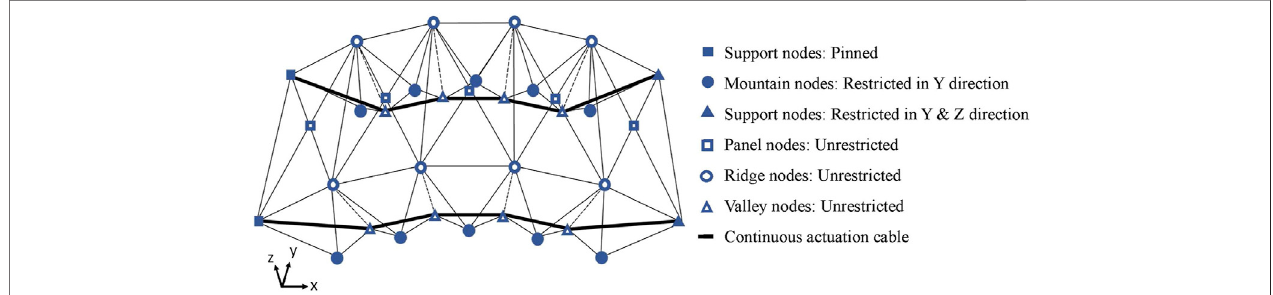
FIGURE3| FivemoduleOPBstructureshowingnodetypesandboundaryconditions.Supportnodes[ieqn8]arepinnedand[ieqn9]arerestricted y and z direction. Valley nodes [ieqn10] are restrained only y direction. Panel nodes [ieqn11], ridge nodes [ieqn12], and mountain nodes [ieqn13]can all move unrestricted. The two actuation cables run through the valley nodes and connect the support nodes on each side.